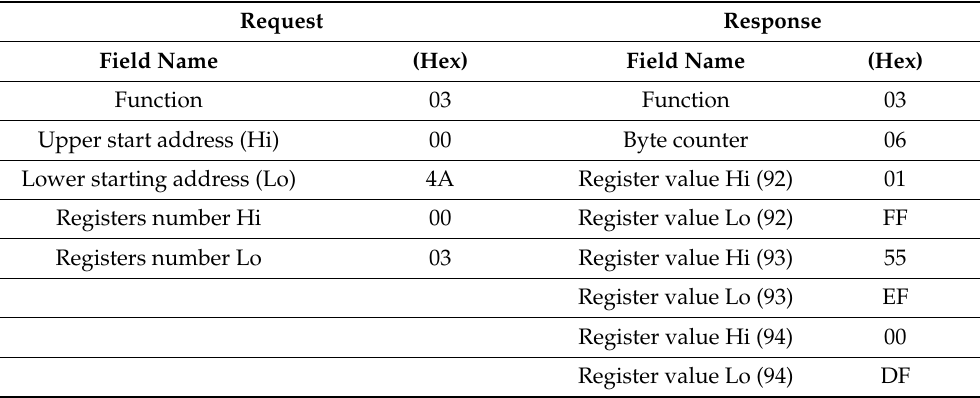
Table 1. Example for reading function FC03.